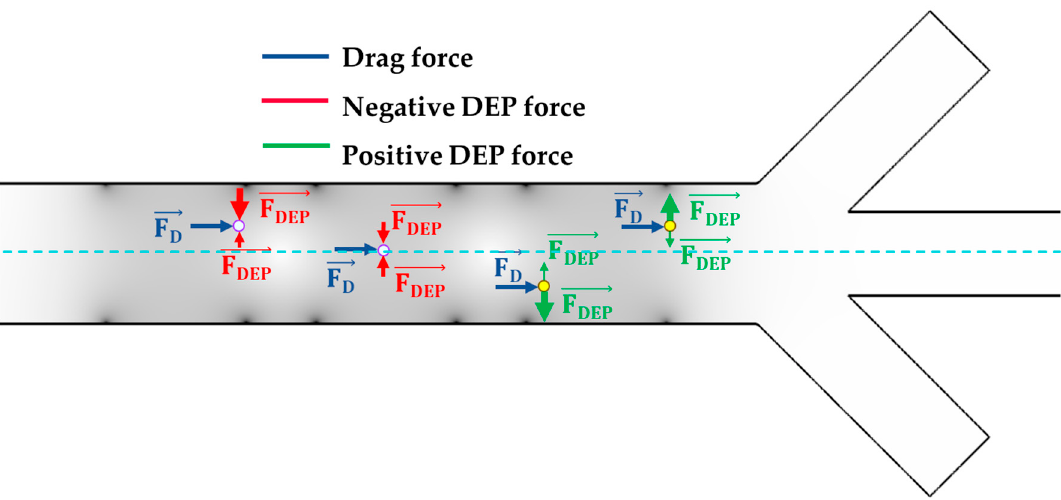
Figure 6. The applied forces on particles at di ff erent y positions.